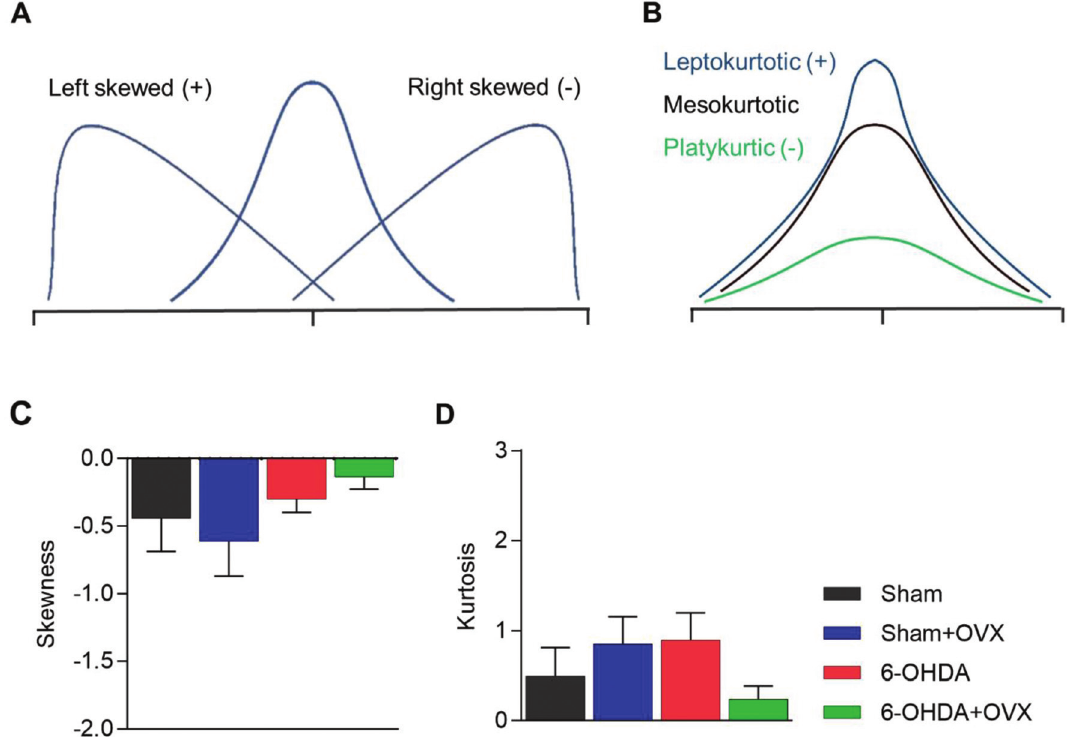
Figure 4 - RRi distribution analysis (A) Representation of the skewness measure in a distribution. (B) Representation of kurtosis in a distribution. (C) Skewness. (D) Kurtosis. Data are expressed as mean ± standard error of the mean. Data are analyzed using GLM multivariate with the Sidak post-hoc test (6-OHDA, 6-hydroxydopamine; OVX,